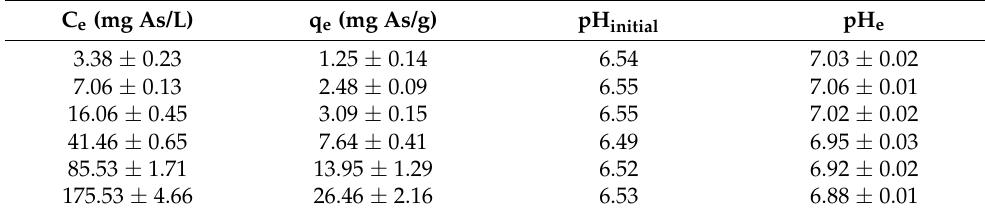
Table 4. Arsenic adsorption onto ChM hydrogel beads at equilibrium at 25 ◦ C and initial pH = 6.5. C e (mg As/L) q e (mg As/g) pH initial pH